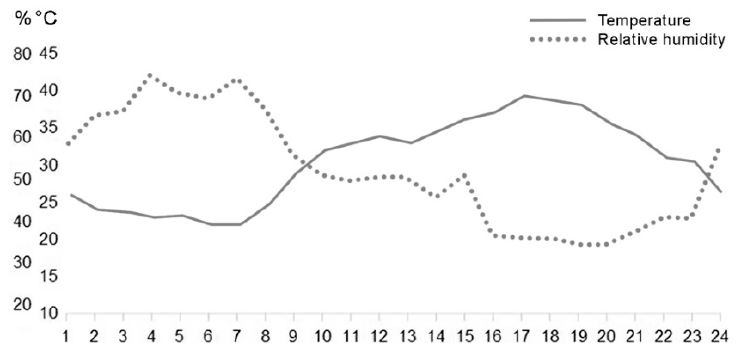
Figure 7. ENVI-met boundary conditions. 2.2. Case Studies The effect of mitigating the UHI was evaluated by intervening on some chosen parts of the city of Ascoli Piceno with suitable devices aimed at lowering local temperatures and increasing wind flow. Four peripheral areas were chosen that were interesting from an urban-planning point of view and in which the thermal environment, by analyzing the UHI, was particularly uncomfortable. Of the four case studies, the first three consist of design proposals for future interventions, while the fourth has already been realized. The first area is a natural terrace located next to the bus station. Multi-floor buildings tower over the area on two sides and the steep embankment of the Castellano River runs along the south side. Although dense vegetation covers the north side of the river, the paved square is one of the hottest places in the city. This is due primarily to its continuous exposure to sunlight and to the heat island generated around the nearby buildings, which is caused by the total lack of ventilation. The same method was applied to another three very similar cases situated at the edges of the historical city center and closely connected to the river system. The various positions and uses of public spaces required different means of intervention, but thanks to the TENS method, it is possible to see an improvement in outdoor comfort during the summer and a positive mitigating influence in the microclimate of the city center. One of these cases was the renovation of the ancient mill (Ex Società Impianti Materiali Elettrici (S.I.M.E.)) on the left bank of the Castellano River to the east of the historical center. Built in 1610, it was continually and radically modified over the centuries until it was completely transformed into an industrial building on the edge of the historical center in the early twentieth century. The goal of the proposal consists in rethinking not only the architecture, but also the urban area that connects the city to the river.